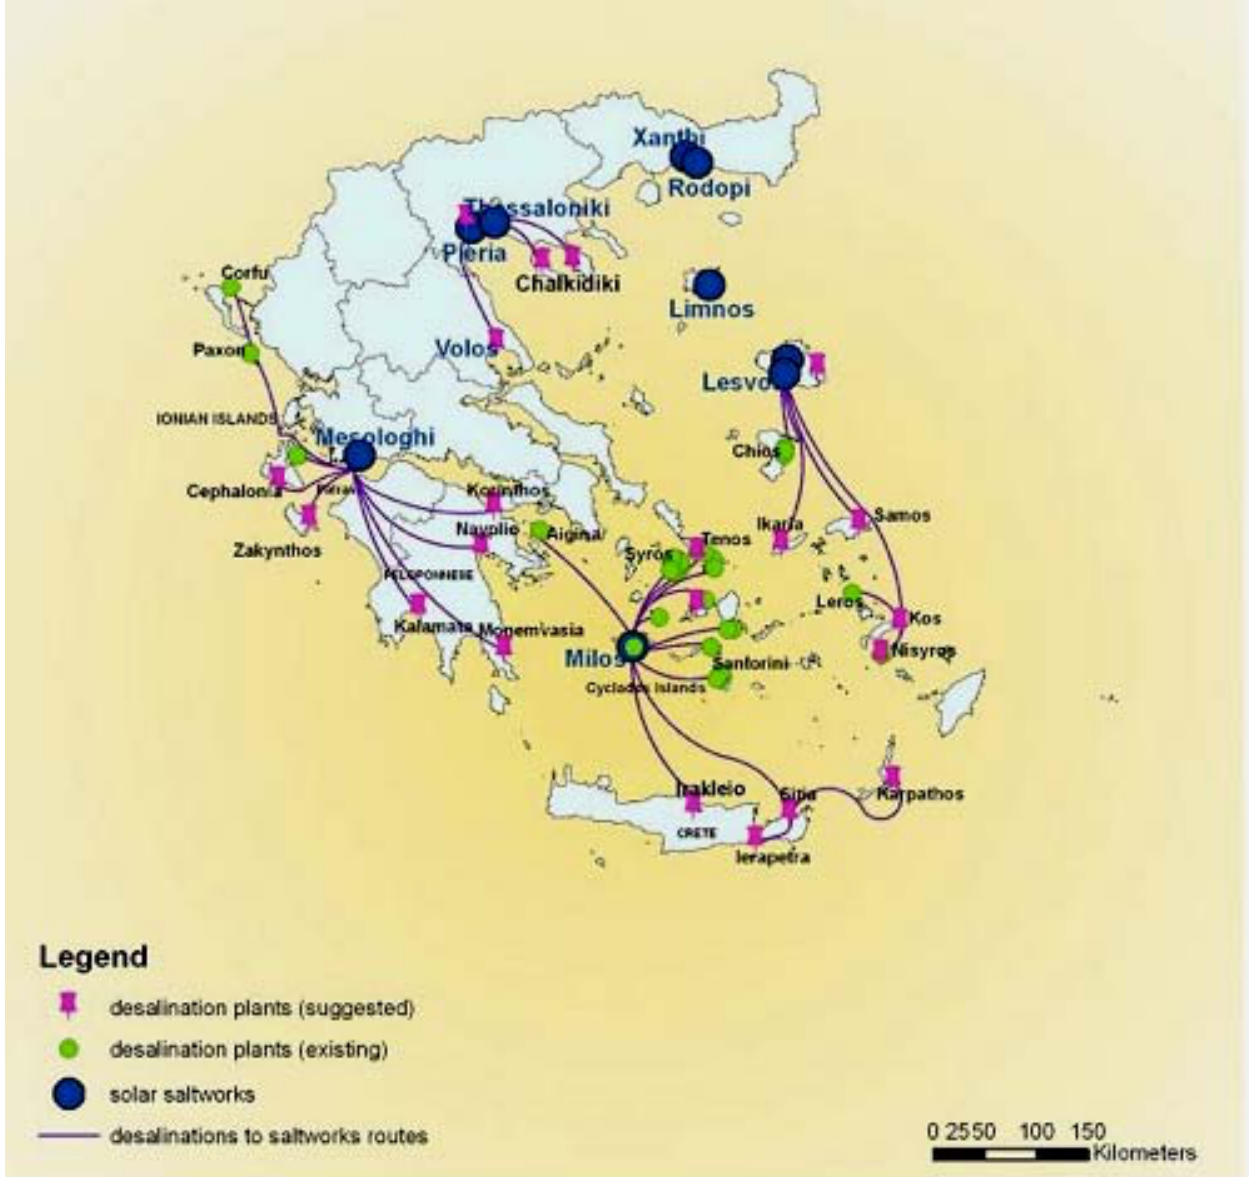
Figure 1. GIS map of Greece with desalination plants (suggested and existing), solar saltworks and routes for the transportation of